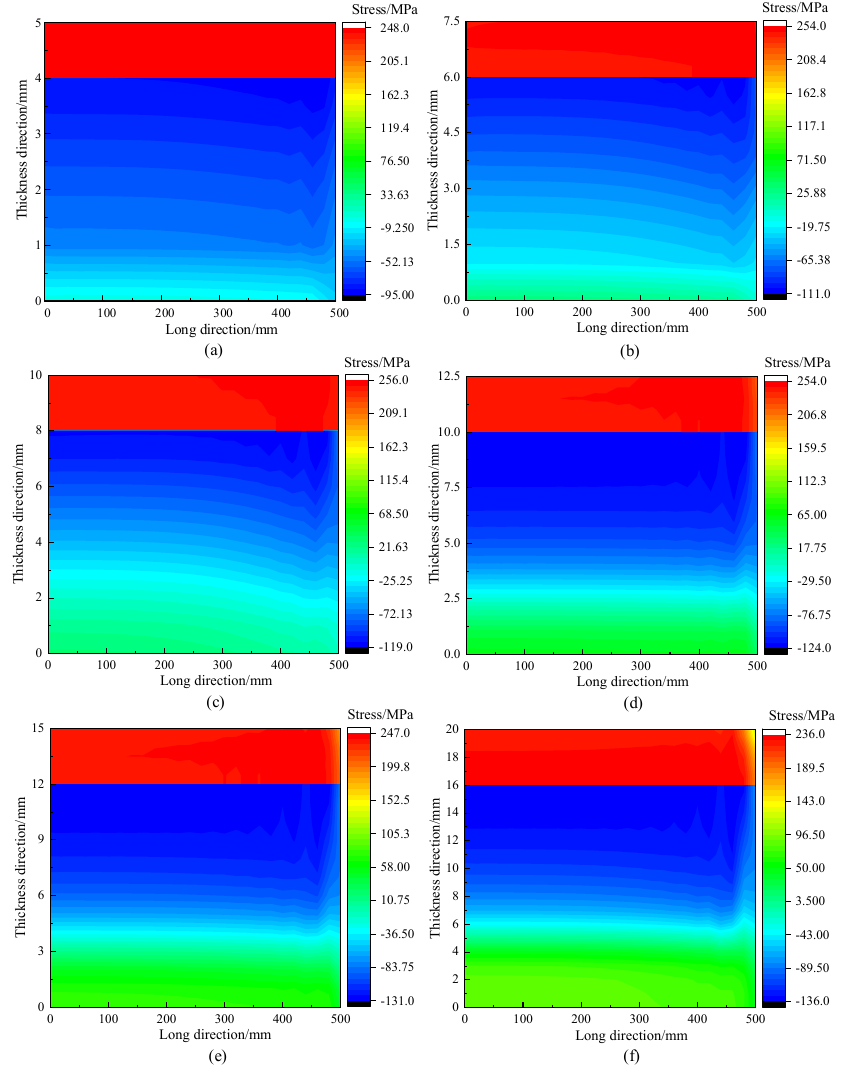
Figure 21. The residual stress distribution of 316L/Q235B composite plate under different total thickness parameters. ( a ) 5 mm; ( b ) 7.5 mm; ( c ) 10 mm; ( d ) 12.5 mm; ( e ) 15 mm; ( f ) 20 mm. It can be seen from that the distribution trend of residual stress of the 316L/Q235B composite plate after heat treatment was approximately the same under different total thickness. As the total thickness increased from 5 mm to 12.5 mm, the residual stress of the 316L cladding layer was evenly distributed, with little change, and the residual stress in region I increased from 243.371 MPa to 244.056 MPa. The residual stress in region III reduced from 243.904 MPa to 243.005 MPa. The residual stress of the Q235B base layer presented a gradient distribution from the interface to the surface and obvious changes with the increase in total thickness: the residual stress at region IV increased from − 87.799 MPa to − 123.656 MPa; the residual stress at region VI increased from 3.019 MPa to 61.681 MPa. When the total thickness increased from 12.5 mm to 20 mm, the residual stress of the 316L cladding layer had changed greatly. The residual stress at region I decreased